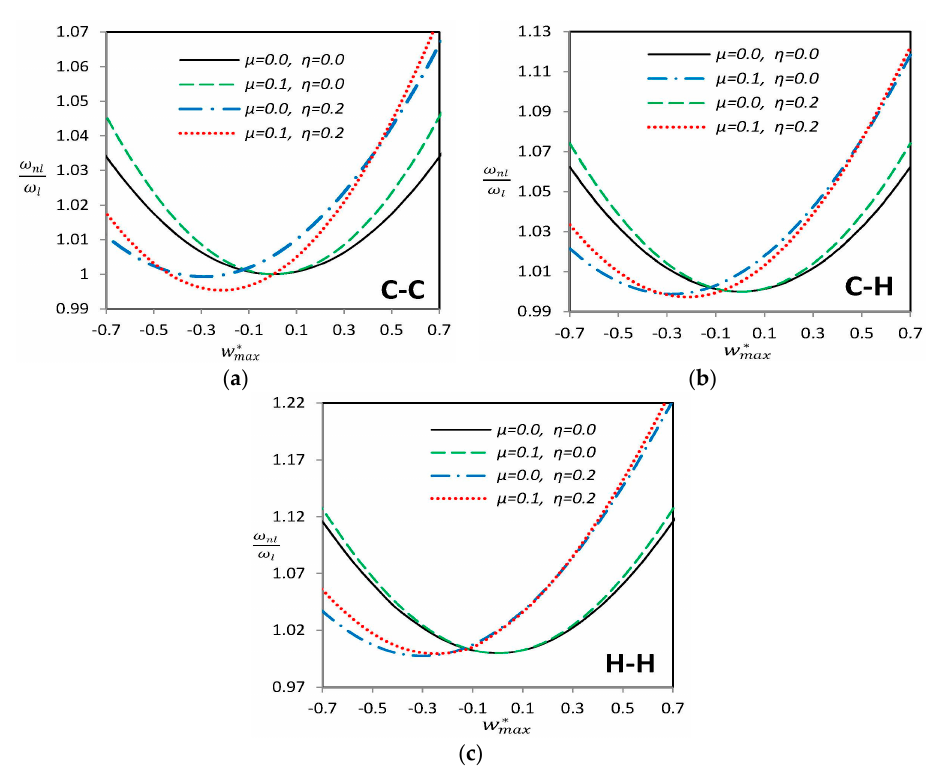
Figure 4. Variation of nonlinear vibration frequency ratio for different combinations of imperfection amplitude η and nonlocal parameter μ for a “G” type imperfection for ( a ) clamped-clamped ( b ) clamped-hinged and ( c ) hinged-hinged endpoint conditions.